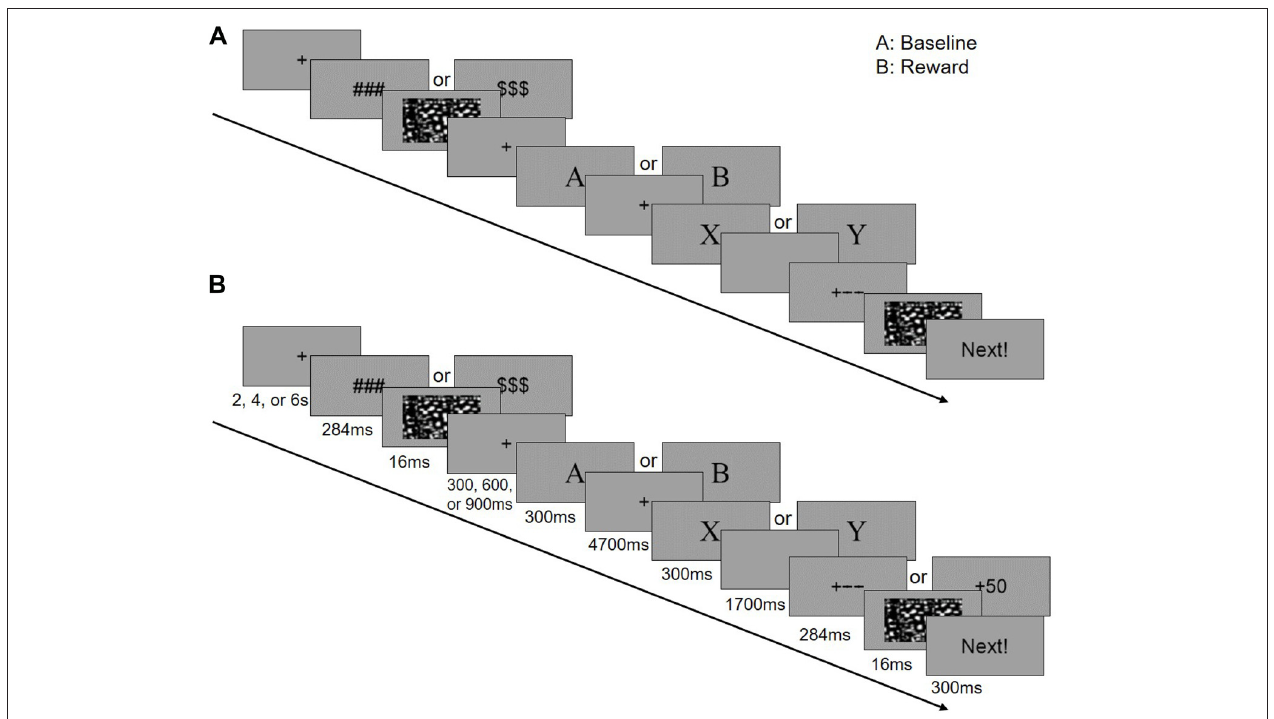
FIGURE 1 | Experimental design of this study. In the scanner, the participants performed a block designed AX-Continuous Performance Task (AX-CPT). There are two runs in the task (a baseline and a reward run), and each run has three blocks (40 trials in each block). The baseline run was followed by the reward run. (A) Single trial for the baseline context. (B) Single trial for the reward